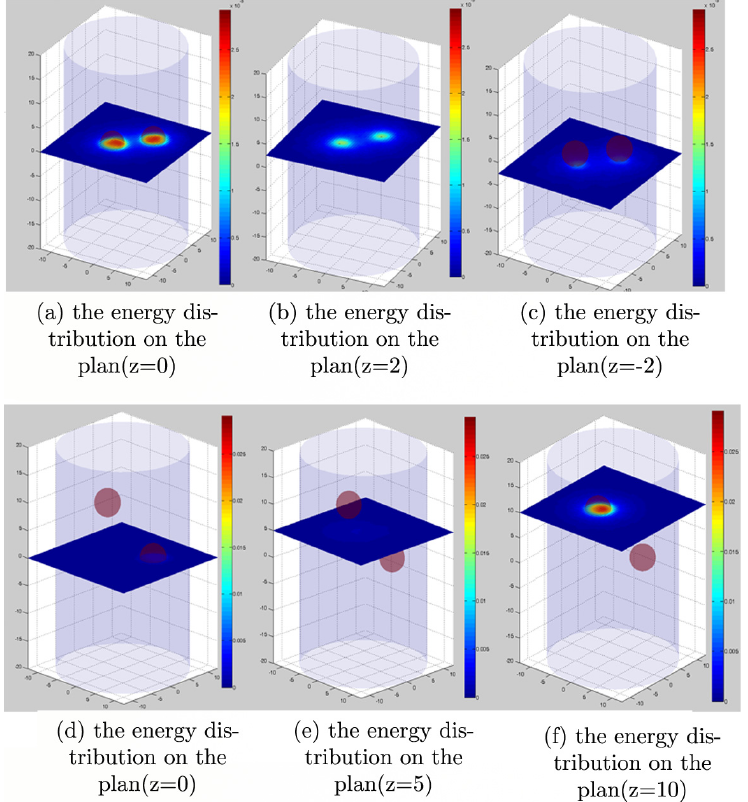
Fig. 6. Fluorescence intensity distribution of two spherical foci.